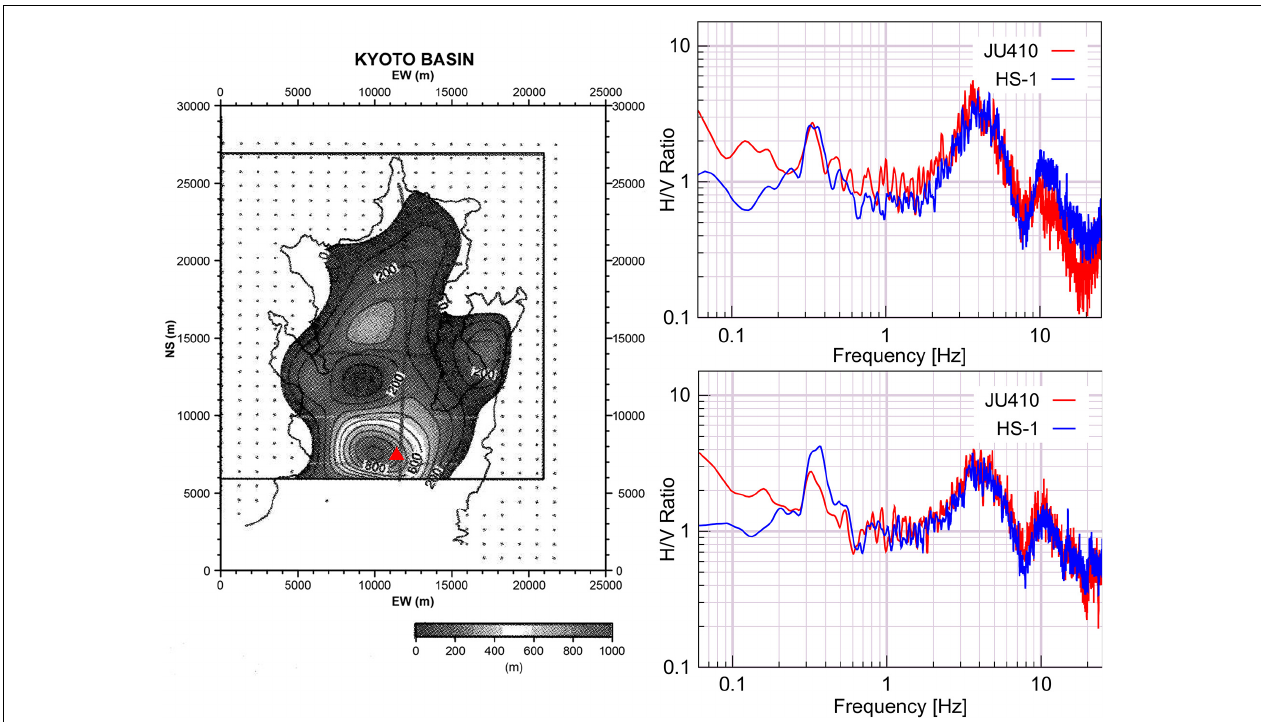
FIGURE 6 | Left: Basin depth of the site used for the comparison inside Kyoto basin (after Kiyono et al., 2001). Right: Comparison of HVSR from two sets of data recorded with JU410 and sensor HS-1 simultaneously.